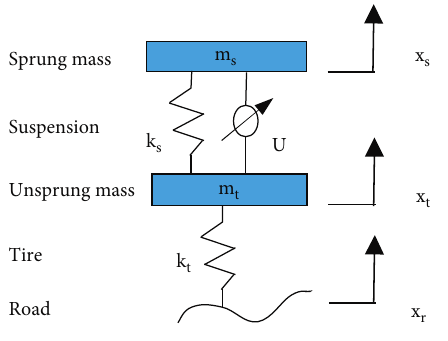
Figure 1: Suspension